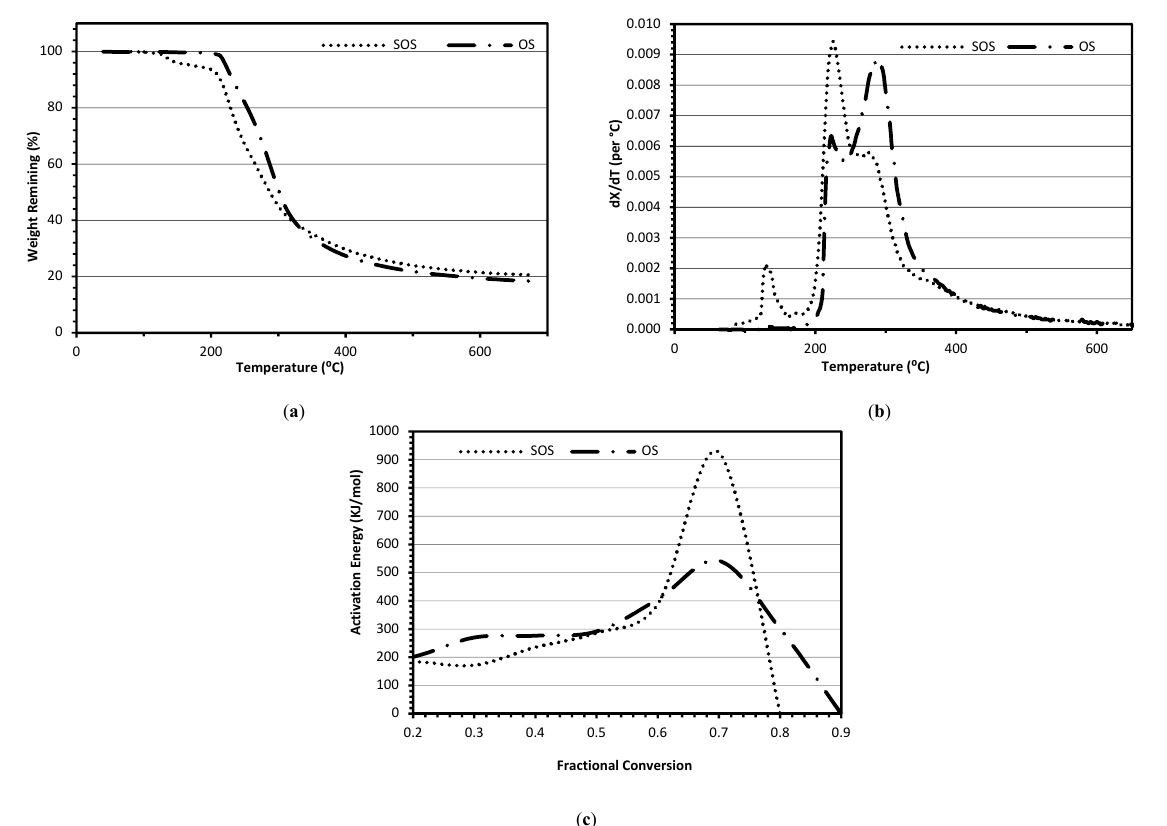
Figure 1. ( a ) Loss of samples weight ( b ) rate of fractional conversion ( c ) activation energy as a function of fractional conversion of thermo-chemical decomposition under nitrogen atmosphere of freeze-dried osmotic solution and spent osmotic solution (SOS) generated from osmotic dehydration of